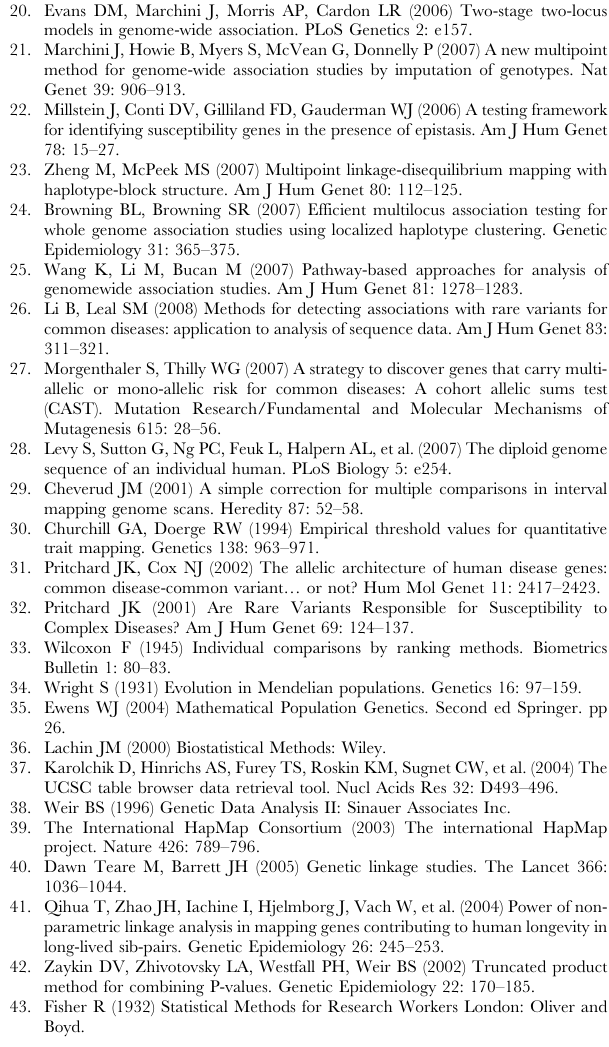
Table S3 Computational Speed. The computation time (in CPU hours) is shown for testing 20,000 groups with 50 polymorphic variants each, using the weighted-sum method. The speed computation is done for different number of individuals ( n = n A = n U ), and different number of permutations ( k ). It is seen that the computation time is linear in the number of individuals and in the number of